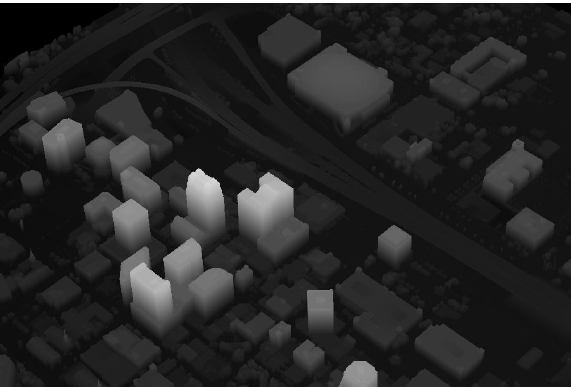
Figure 2b. An image showing the 3D coordinates associated with the oblique image in Figure